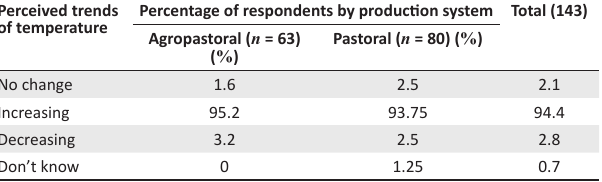
TABLE 3: Perception of respondents on trends of temperature in the study area. Perceived trends of